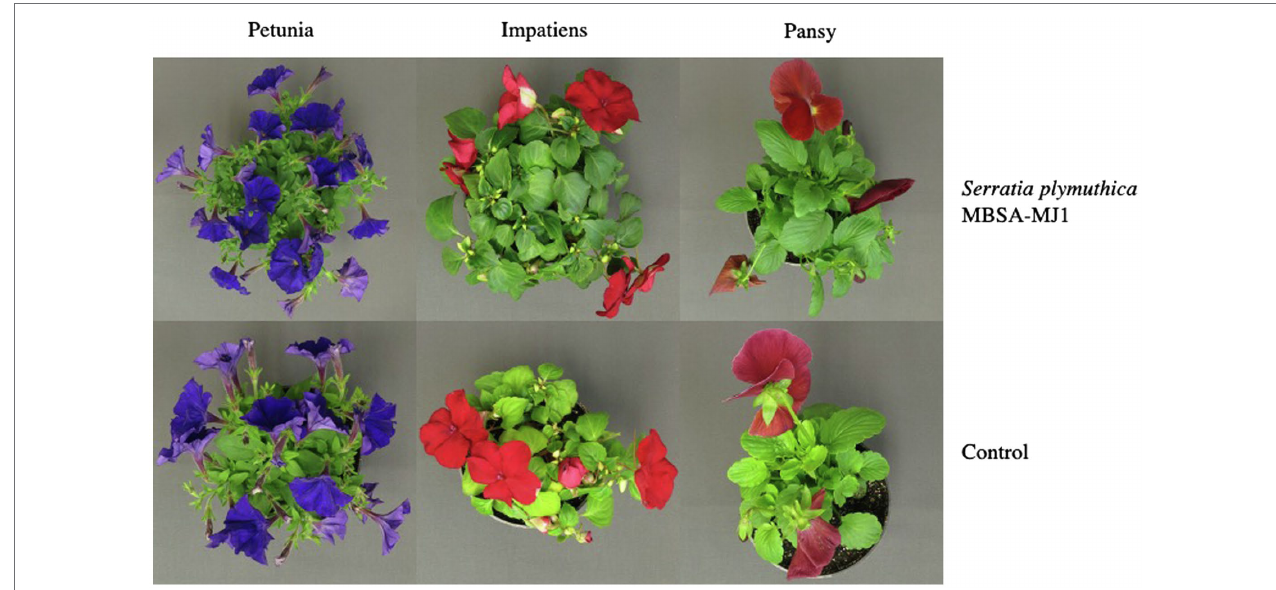
FIGURE 1 | Petunia × hybrida (petunia), Impatiens walleriana (impatiens), and Viola × wittrockiana (pansy) plants grown under low-nutrient conditions had increased visual quality when treated with Serratia plymuthica MBSA-MJ1. Plants were treated weekly for 8 weeks with S. plymuthica MBSA-MJ1 or uninoculated LB (control) as a media drench and fertilized at each irrigation with 25 mg L − 1 N from 15N–2.2P–12.5K–2.9Ca–1.2Mg water soluble fertilizer to induce low-nutrient